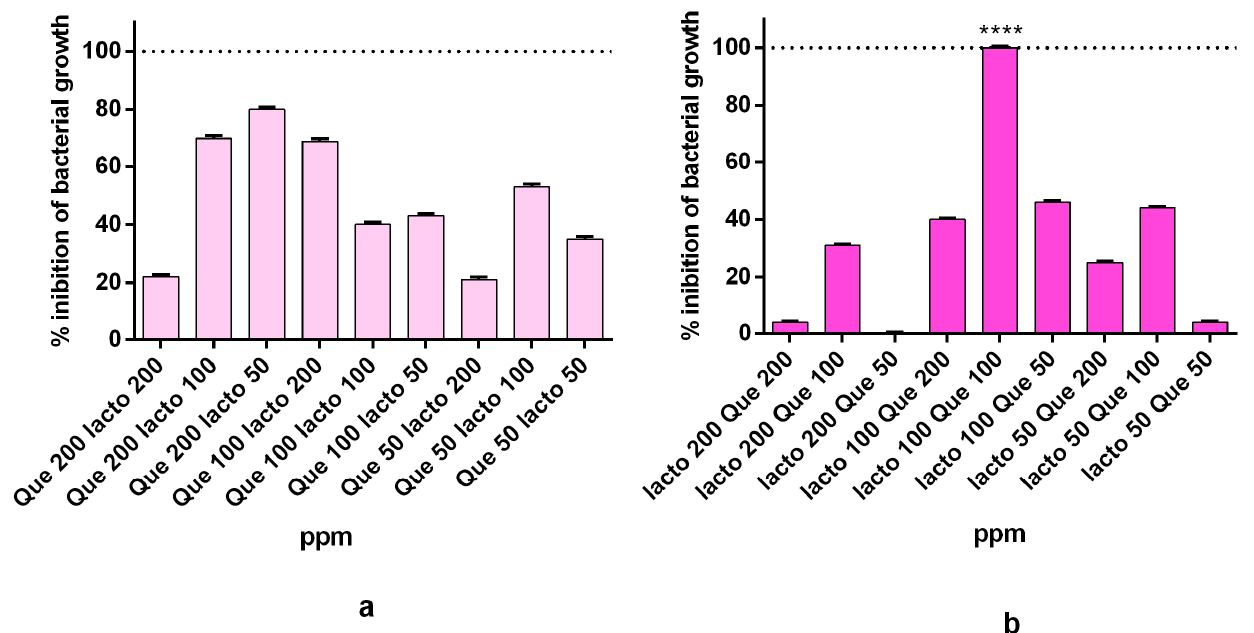
Figure 3. Antimicrobial activity of the Que and Lacto complex against Pseudomonas fluorescens (10 6 CFU/mL). Different concentrations of Que and Lacto were absorbed on HA. The absorption order was Que and then Lacto ( a ) Lacto and then Que ( b ). Statistical analysis was performed and considered statistically significant when p < 0.05 (**** p < 0.0001) according to two-way ANOVA multiple comparisons.